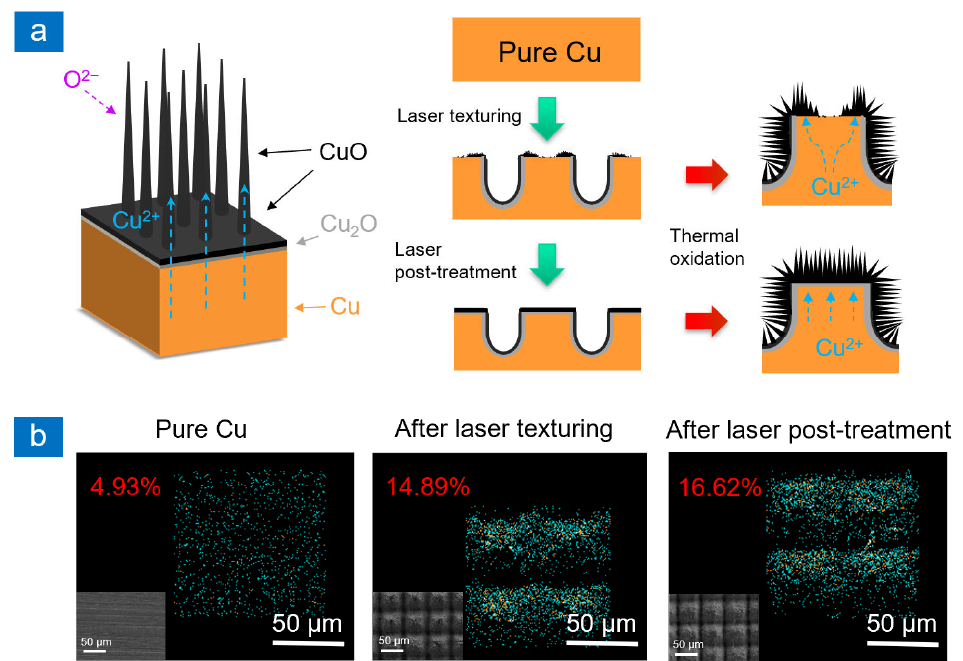
Figure 3. ( a ) Growth mechanism of CuO nanowires on surface without or with the laser post ‐ treatment. ( b ) EDS images of oxygen atomic percent and corresponding